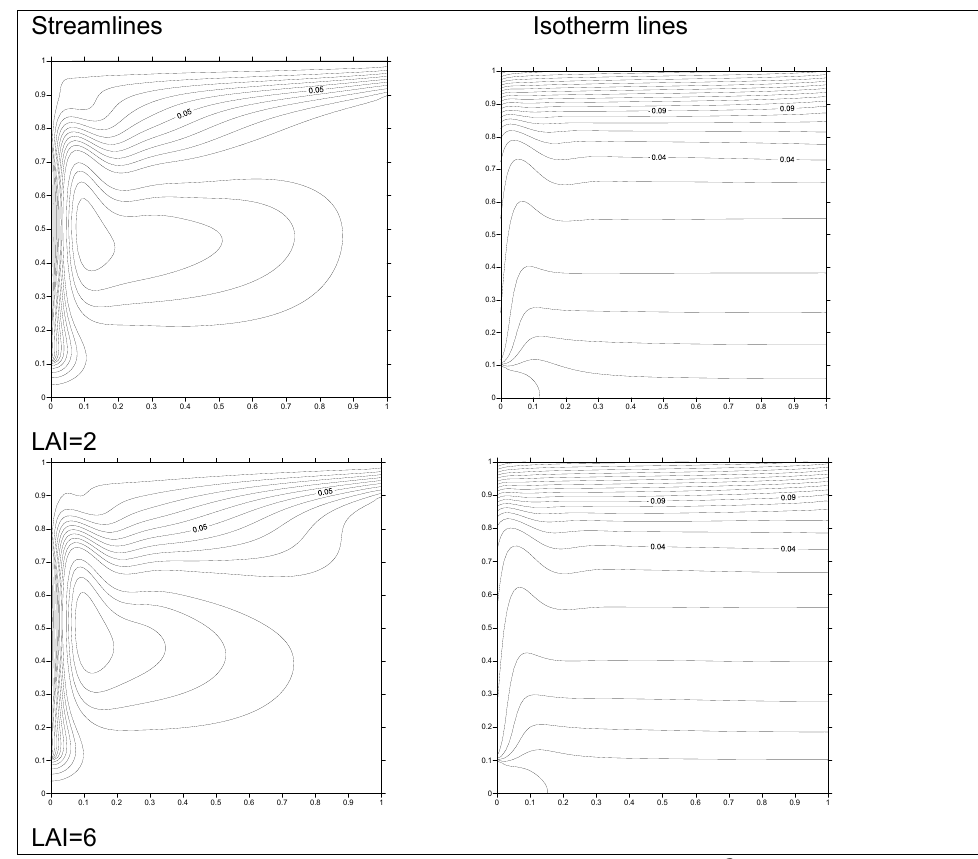
) = 200 𝑊/𝑚 2 Figure 4 . Streamlines and isotherm lines for 𝑅𝑛(𝑍 𝑅 It can be seen from figure 4 that the natural convection effect is present but remains relatively weak for higher values of the Leaf Area Index since open lines characterizing the imposed flow are still slightly dominant. The lower recirculation zone spreads and thereby squeezes the induced flow path resulting in almost the same kinetic energy in the bulk induced flow as that of the inlet section. Convection heat transfer induces the growth of the recirculation cell resulting in the faster removal of heat and mass from the heat and water sources. When the buoyancy force increases with the increase of heat flux and concentration gradients, the recirculation zone begins to develop by absorbing thermal energy through induced forced flow. Thereby the squeezed induced flow covers the whole of the heat and water source at low LAI. Similarly, the effect of natural convection on the temperature and water vapour concentration distribution is characterized by the displacement of the isotherm, isoconcentration and isohumidity fronts throughout the cavity. But, since the induced flow sweeps over the heat and water vapour concentration level to the left upper corner of the cavity decrease indicating a better heat and water vapour transfer. As transfer numbers increase nonlinearily, isotherm, isoconcentration and isohumidity lines become higher and plume formation is profound, indicating a well-established natural convection double diffusive flow. In this case, heat conduction in the fluid becomes more important than convection heat transfer (isotherm lines of figure 4). Furthermore, the distributions of isotherms and isoconcentrations describe a vertical stratification of air temperatures and